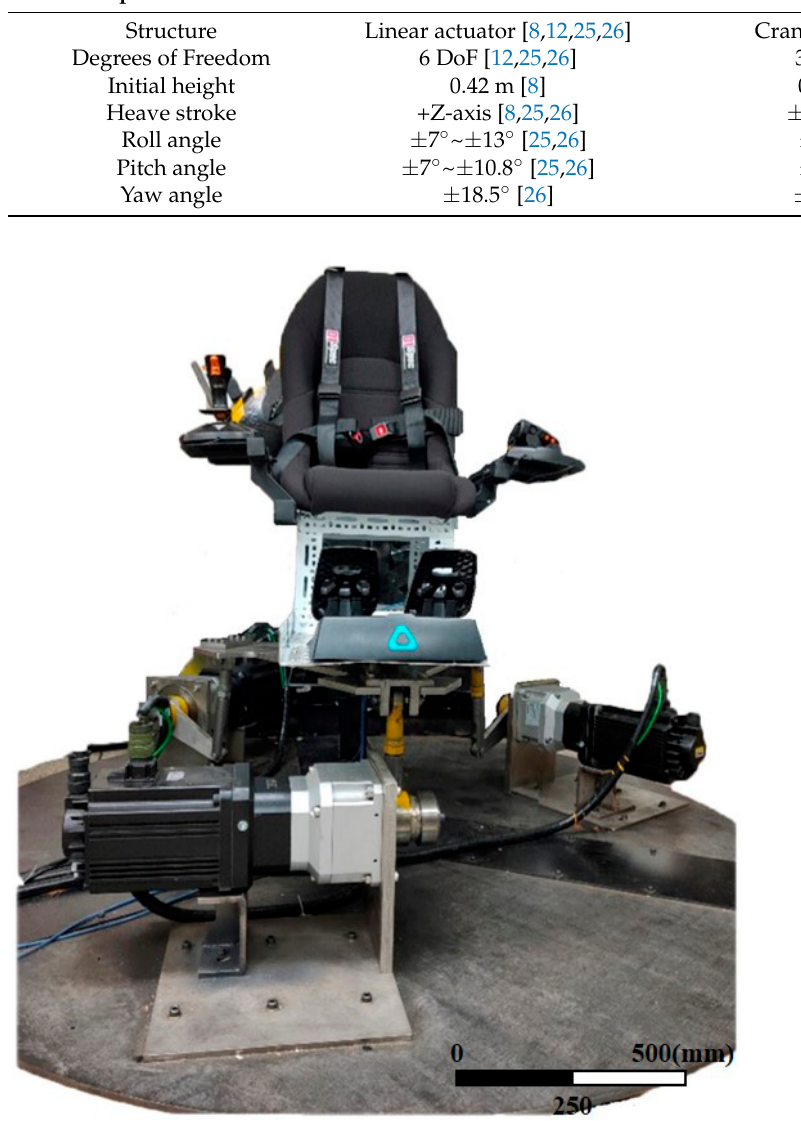
Figure 33. Operating state of the system. 4. Conclusions and Future Work Most prior research focused on a 6DoF electric linear actuator platform equipped with a monitor to design the simulator. This kind of design exhibited a smaller motion range than those developed in this study, and the monitor as an image output did not have an immersive feeling for testers. Therefore, this paper developed a rotatable multi- axis motion platform combined with VR digital content. The whole platform system in- cluded inverse kinematics, mechanical design, stress analysis, VR development, and in- teractive control. It allowed testers to achieve immersive VR flight training by watching and controlling VR imagery of a flight and experiencing the feedback brought by the